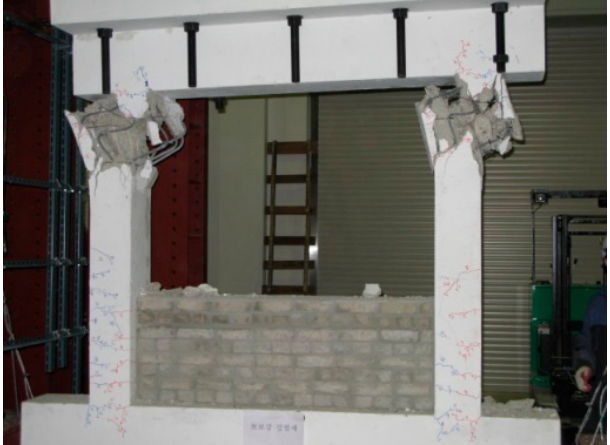
Figure 6. The RCFR specimen following the cyclic loading test.